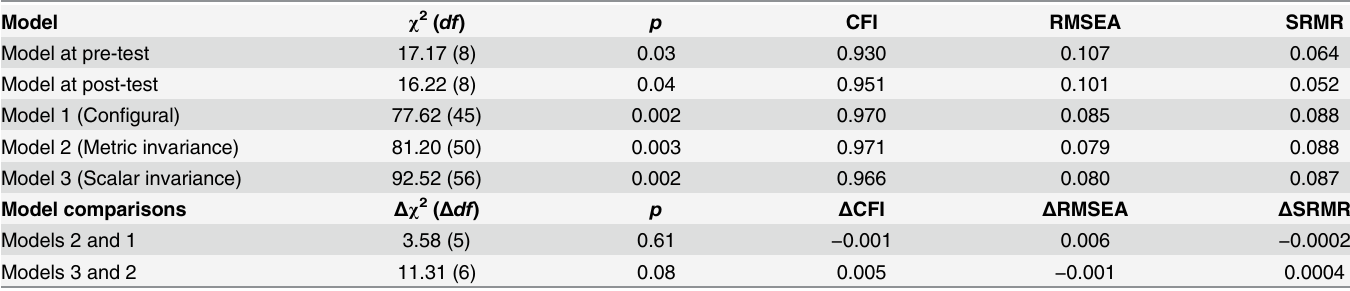
Table 4. Measurement invariance of Chi-PCOSQ across